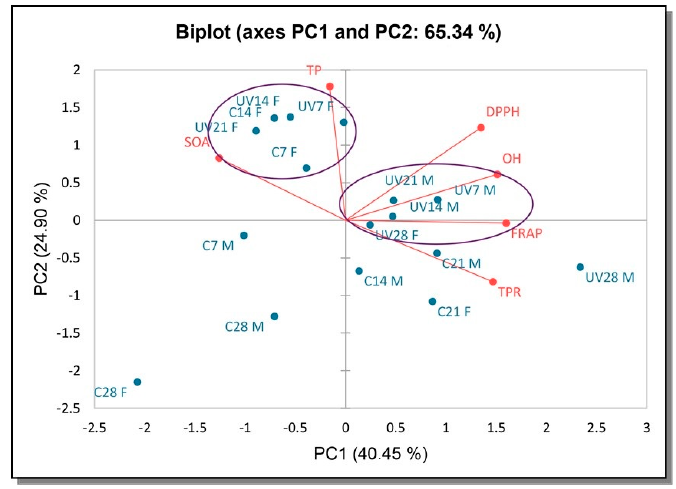
Figure 2. PCA of the AO properties and total contents of AO component of irradiated UV samples and control for T. versicolor . UV-samples exposed to UV irradiation, C-control, F-filtrate, M-mycelia biomass, 7, 14, 21, 28—days of incubation.